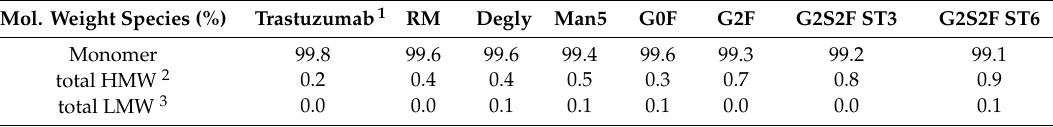
Table 3. Relative quantification of trastuzumab size variants (SEC-UV). Mol. Weight Species (%) Trastuzumab 1